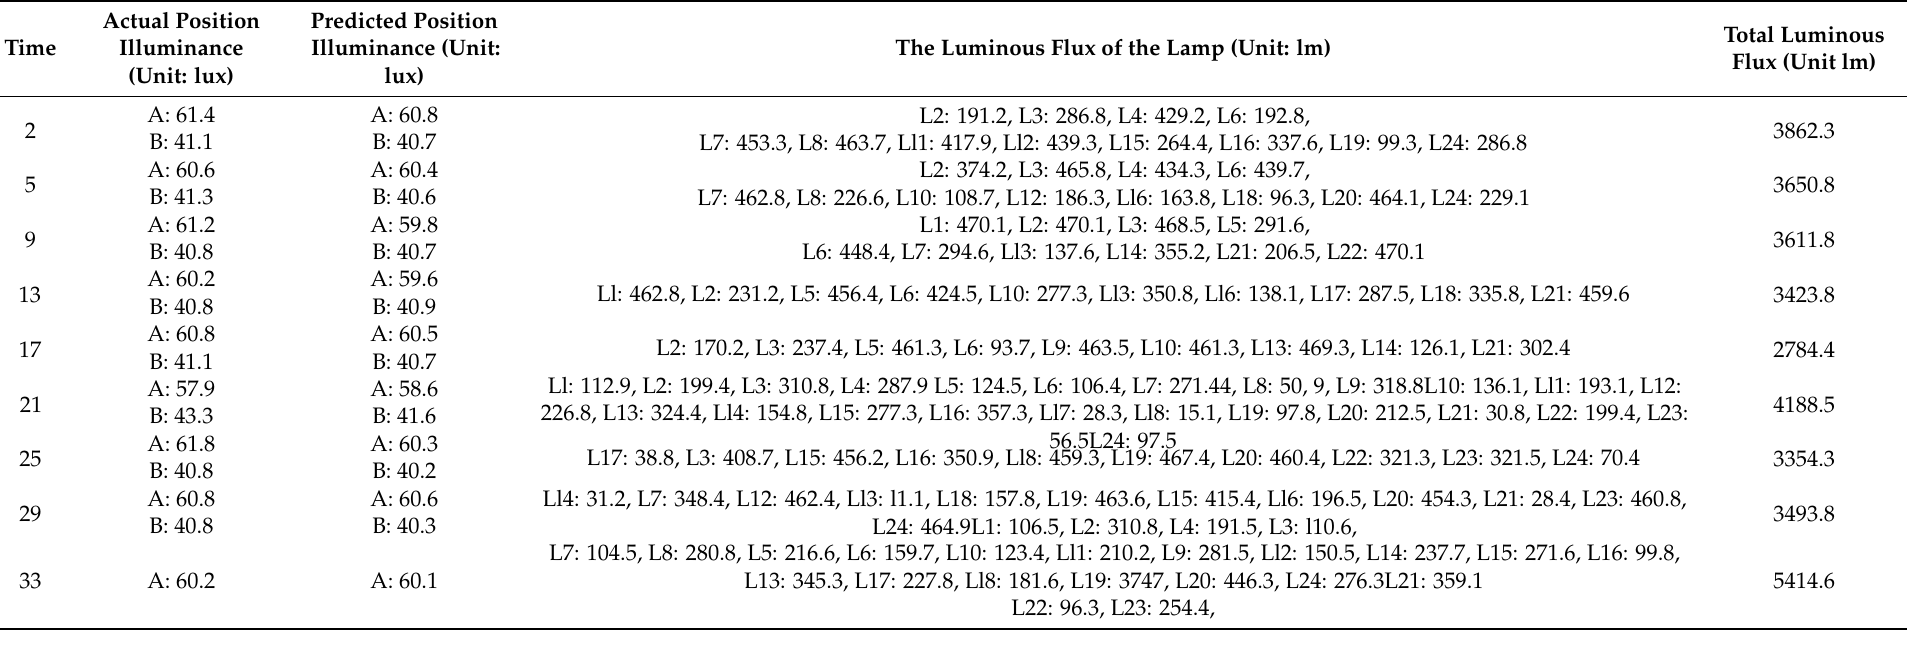
Table 8. Experimental lighting control